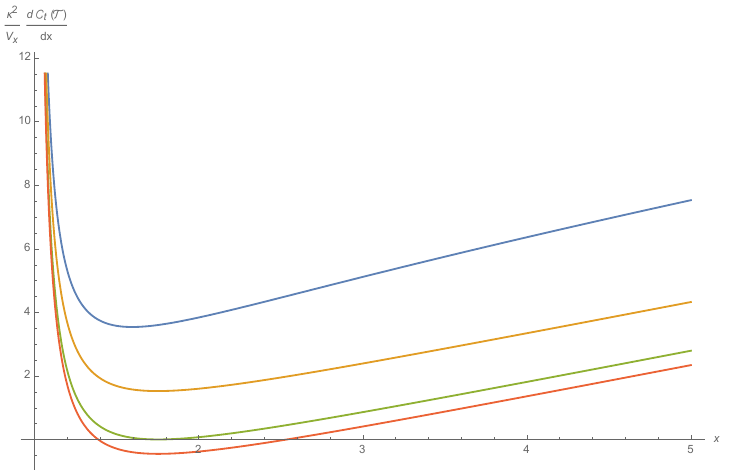
Figure 2. Time derivative of the HPIC as a function of x = | t 0 | /(cid:15) for time-like Q in d = 2 . The curves are for different values of T . From top to bottom T = { 1 . 05 , 3 . 00 , 12 . 77 , 20 . 03 }